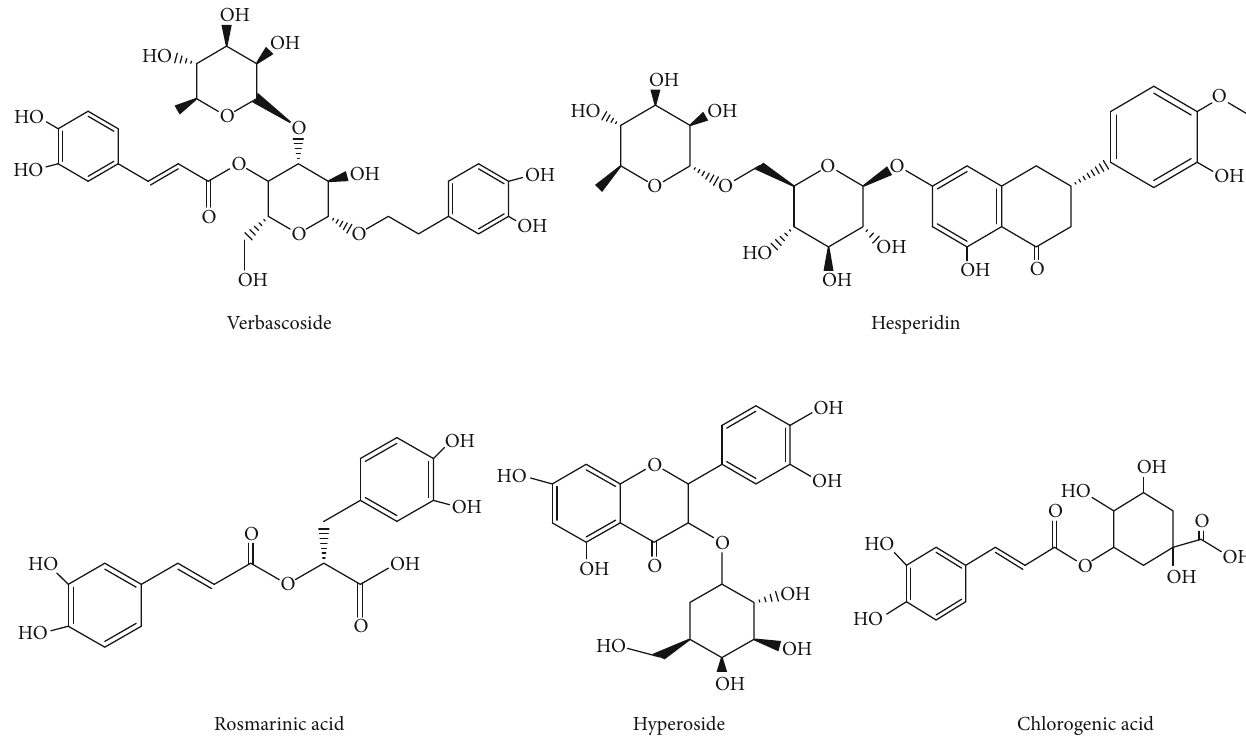
Figure 3: Major phenolic compounds of P. lanceolata